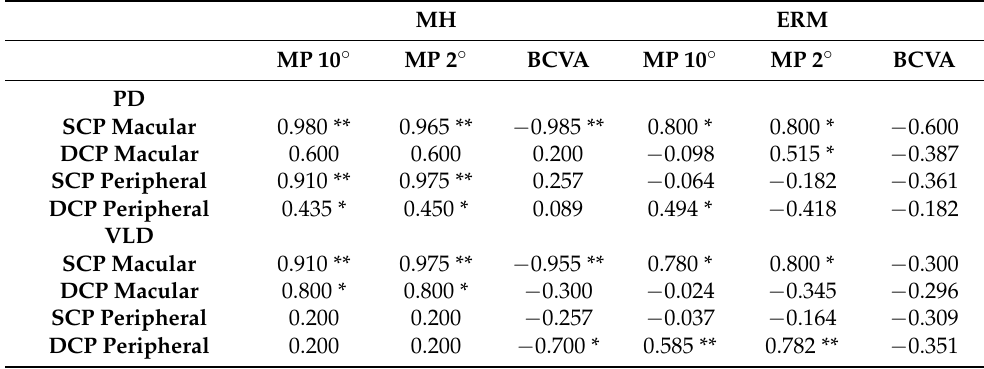
Table 4. Spearman’s Rho correlation coefficient among absolute variation of functional parameters and absolute variation of retinal perfusion